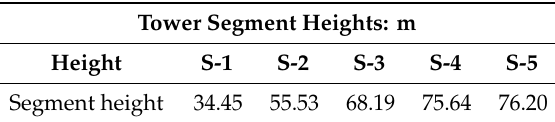
Table 1. Lattice tower segment